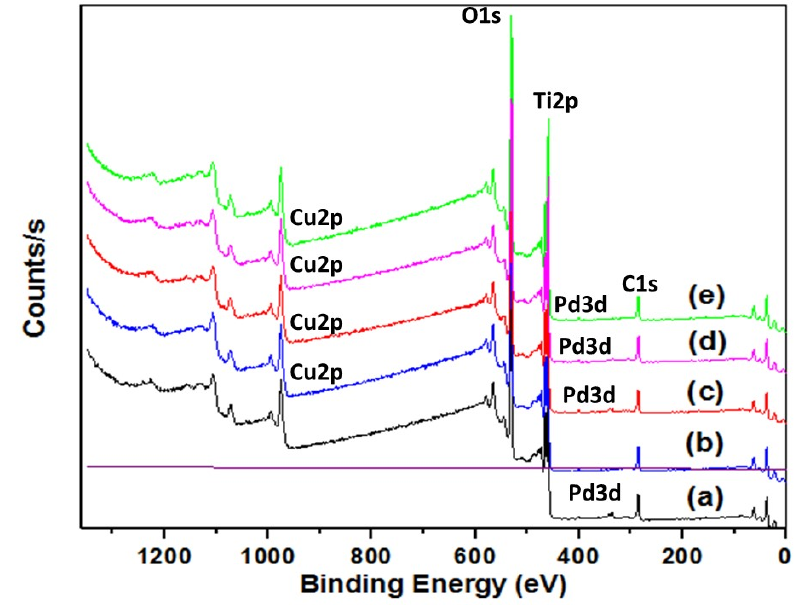
Figure 3. XPS survey spectrum of the prepared catalysts ( a ) 1% Pd/TiO 2 , ( b ) 1% Cu/TiO 2 , ( c ) 0.75Pd- 0.25Cu/TiO 2 , ( d ) 0.25Pd-0.75Cu/TiO 2 ( e ) 0.5Pd-0.5Cu/TiO 2.